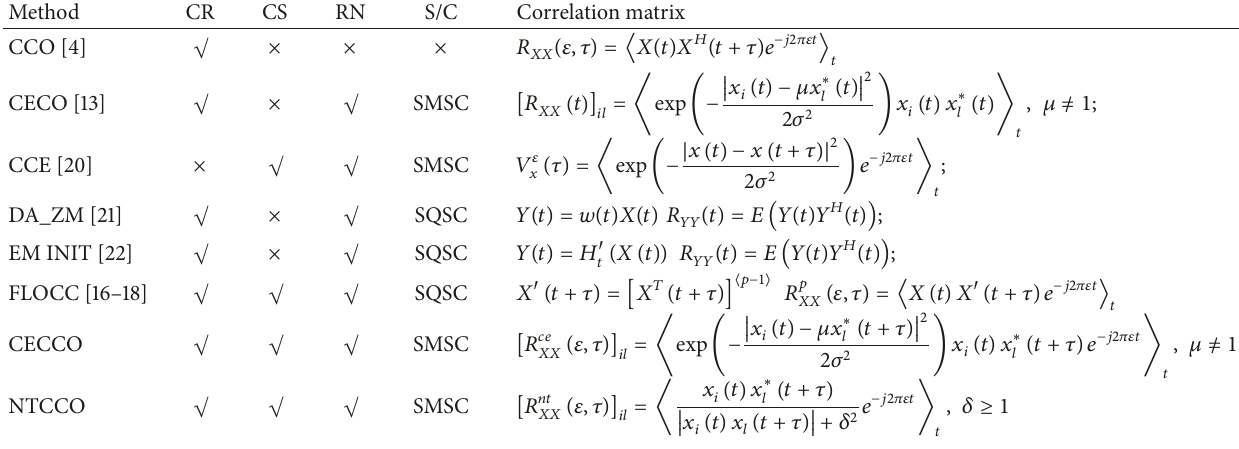
Table 1: The summarization of the different